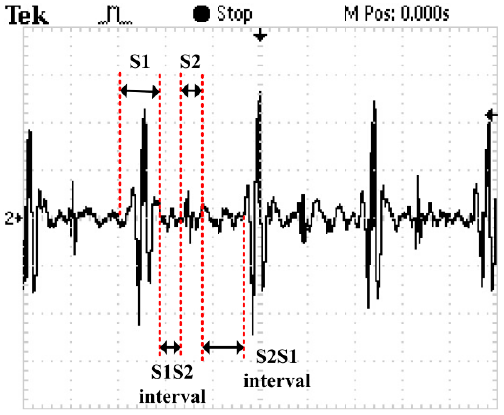
Figure 13. Waveform tested by the MEMS electronic heart sound sensor.